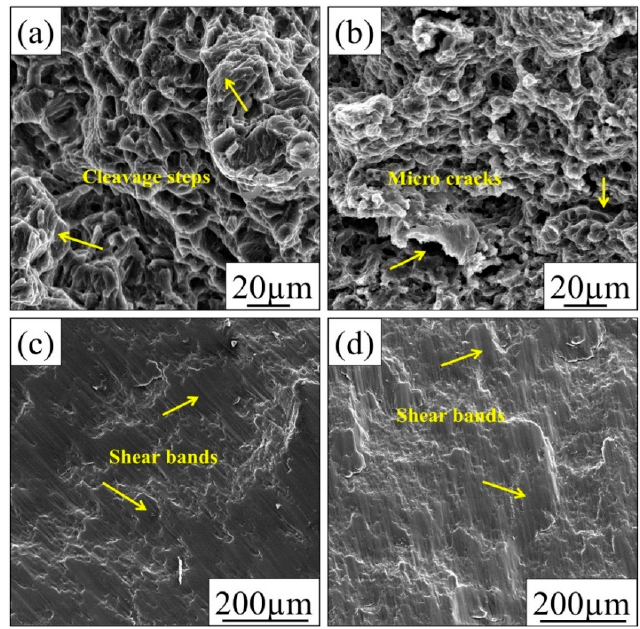
Figure 16. Tensile fracture surface of extruded ( a ) AZ61 alloy, ( b ) AZ61–3GNP nanocomposite; and compressive fracture surface of extruded ( c ) AZ61 alloy and ( d ) AZ61–3GNP nanocomposite [183] (Copyright Elsevier, 2016, Materials & Design).